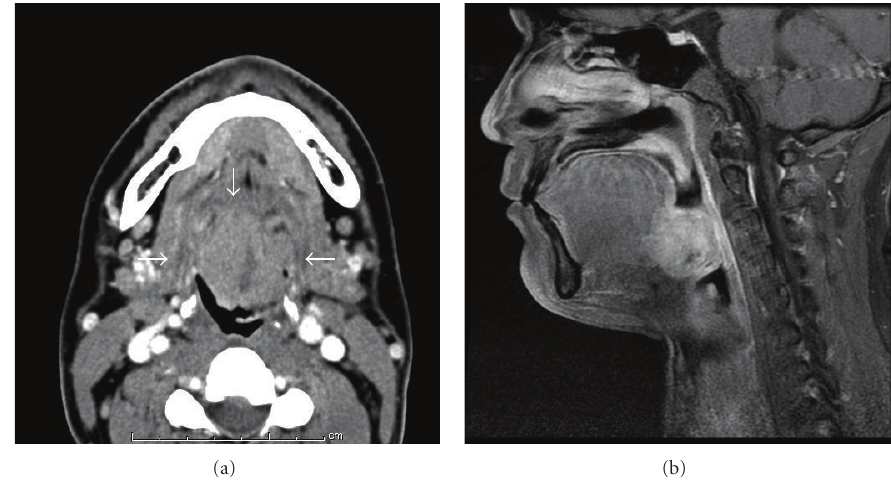
Figure 2: (a) An invasive tumor with a flat and smooth surface is seen at the midline of the base of the tongue (axial view of CT). (b) Enhanced MRI reveals a well-contrasted tumor, while the lower portion of the oropharynx is nearly closed (sagittal view of MRI).